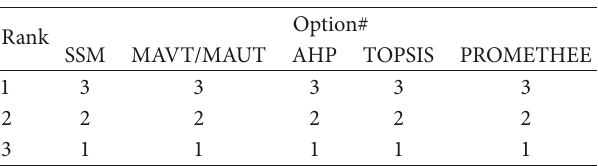
Table 10: Options ranking results using different MCDA methods (“equal